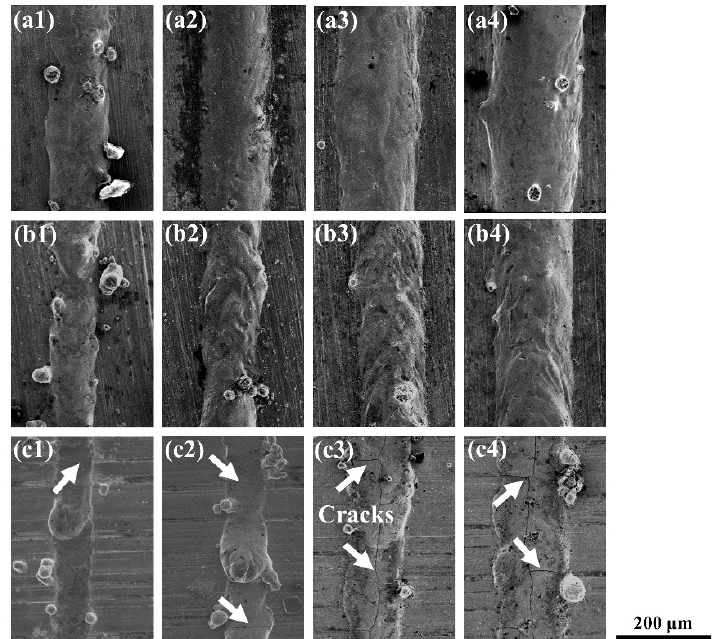
Figure 4. The high-magnification SEM micrographs of single tracks corresponding to Figure 3, ( a1 – a4 ) single tracks formed on the 316L substrate with laser power from 95 to 185 W; ( b1 – b4 ) single tracks formed on the Ni200 substrates with laser power from 95 to 185 W; ( c1 – c4 ) single tracks formed on the YG15 substrate with laser power from 95 to 185 W; the red arrows indicate the cracks on single